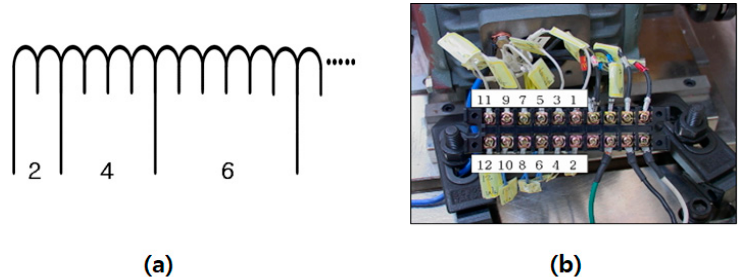
Figure 9. Filtering process for noise in the input power: ( a ) before filtering and ( b ) after filtering.